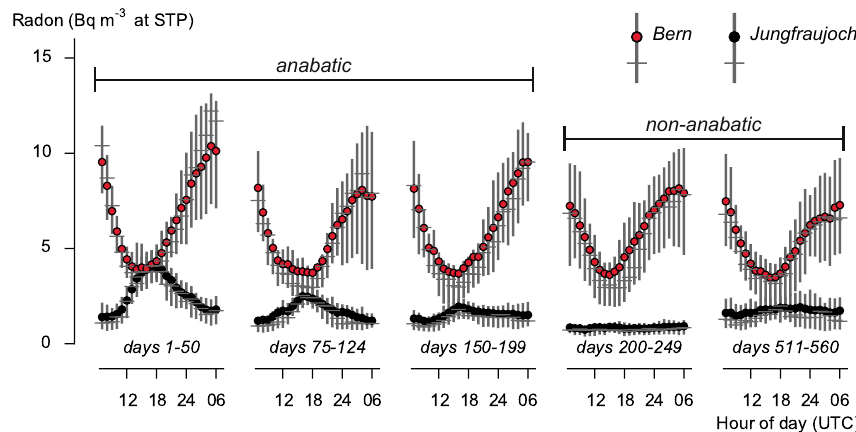
Figure 5. The 50-day diurnal composite radon concentration by anabatic rank. The air mass is fully mixed between Bern and Jungfraujoch during the afternoon on days with a rank of 50 or less; days with a rank of 200 or more are considered to be unaffected by anabatic winds. The symbols have the same meaning as in Fig. 4.